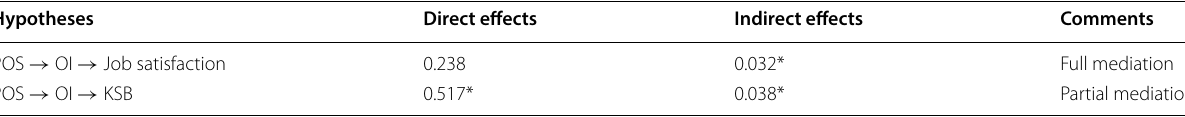
Table 6 Mediation effects